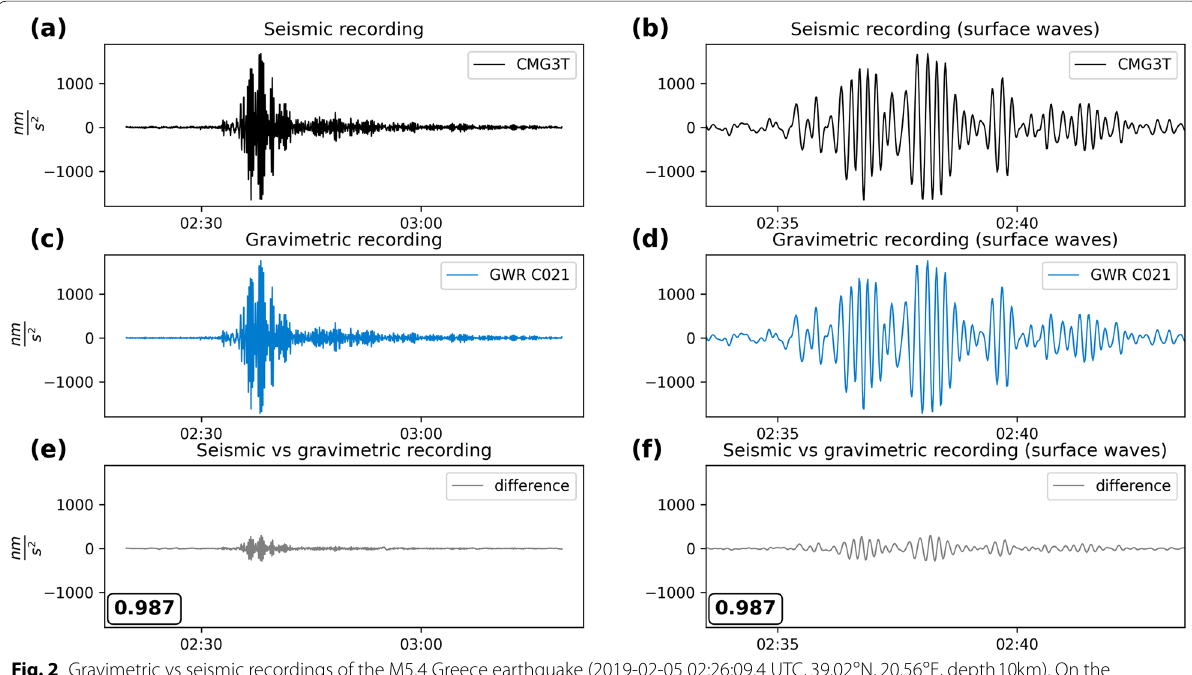
Fig. 2 Gravimetric vs seismic recordings of the M5.4 Greece earthquake (2019‑02‑05 02:26:09.4 UTC, 39.02 ◦ N, 20.56 ◦ E, depth 10 km). On the left‑hand side a , c , e full gravimetric (blue) and seismic (black) recordings of the earthquake from the Membach station and on the right‑hand side ( b , d , f ) only surface waves are presented. In the left bottom corners, the parameter of correlation between seismic and gravimetric data are shown together with signal differences (subfigures e , f )